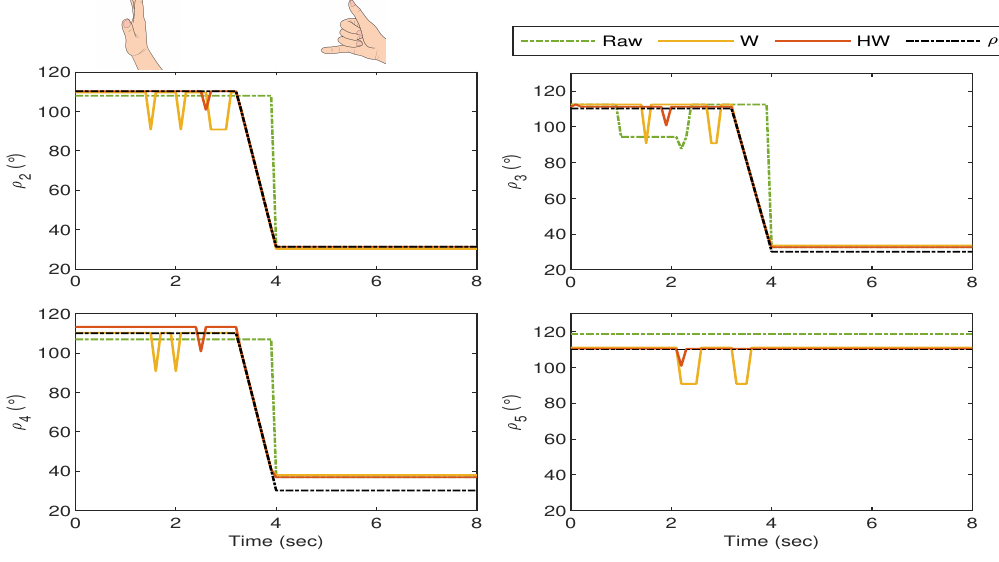
Figure 18. Gesture 3: The mismatch between the glove’s and bionic hand’s goniometry is minimal when Compensator HW is applied as compared to the others.